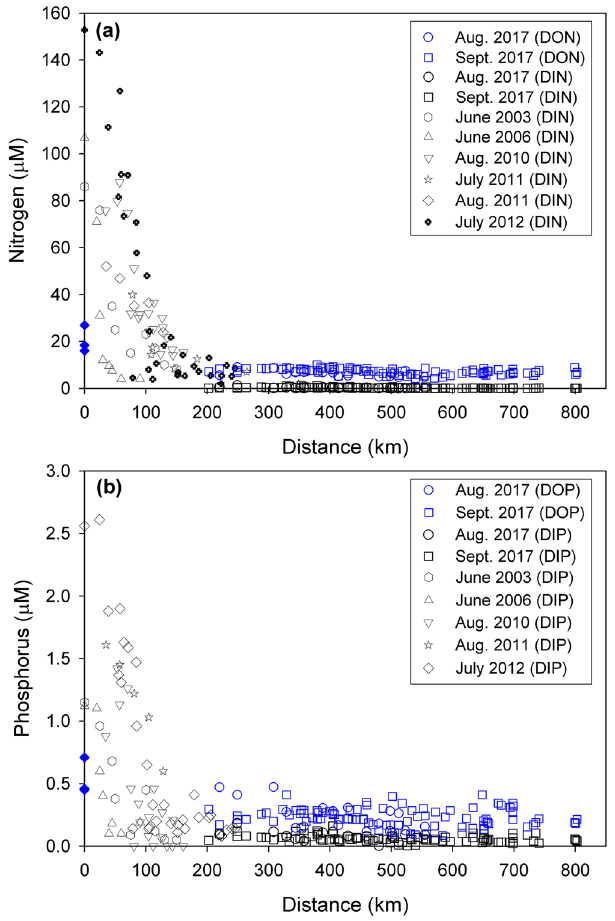
Figure 3. Distributions of ( a ) nitrogen (DIN and DON) and ( b ) phosphorus (DIP and DOP) in surface waters plotted against distance off the Changjiang estuary during the summer. The reference data between 2003 and 2012 are obtained from Chen et al . 17,18 and Gao et al . 19 . The blue filled symbols denote DON and DOP concentrations in the Changjiang River obtained from Liu et al . 26,27 and Shen and Liu 28 . The distances were calculated between Chongming Island (located in the Changjiang estuary) and each sampling station using the latitude and longitude of those